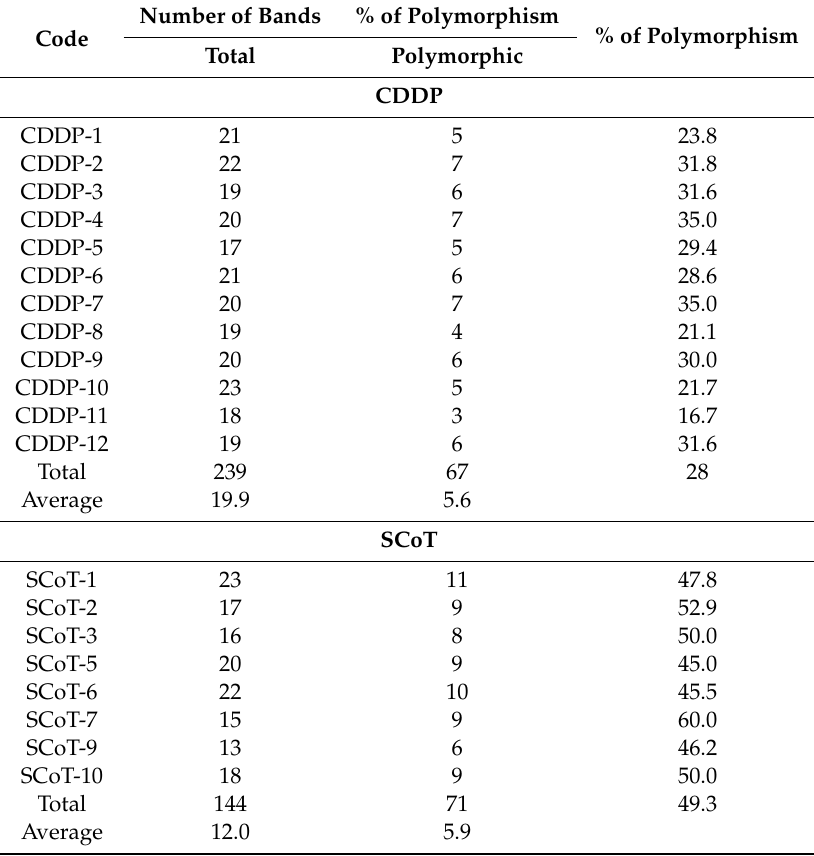
Table 1. Primer code, total number of bands, number of polymorphic bands and percentage of polymorphism in the Start Codon Targeted Polymorphism (SCoT) and Conserved DNA-Derived Polymorphism (CDDP)